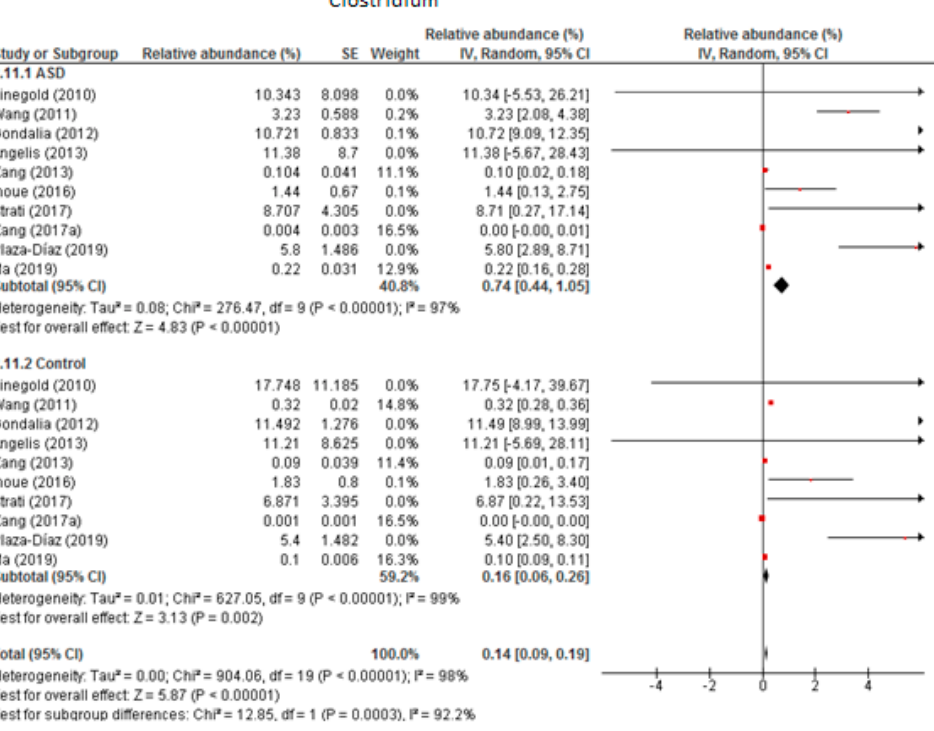
Figure 5. Forest plot of relative abundance of Clostridium in children with ASD and controls.